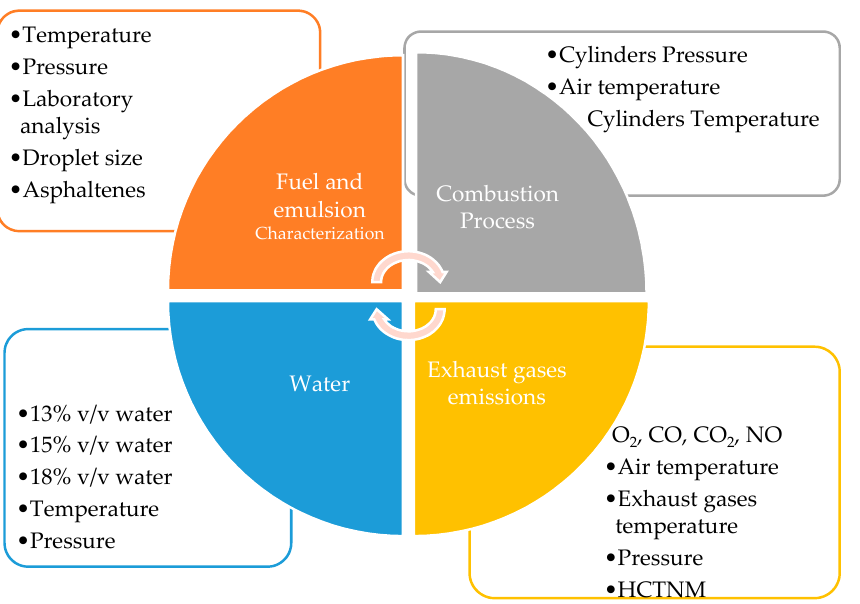
Figure 3. Diagram of the monitoring and control system designed for this research study including the variation of cylinders and exhaust gases emissions temperature ( ∆ T), total hydrocarbons (HC) and total hydrocarbons unburned without methane